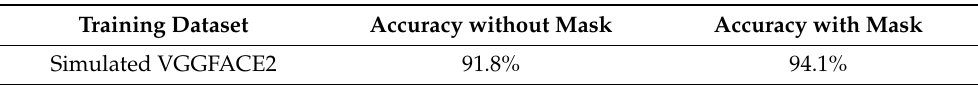
Table 6. The accuracy of face recognition without and with a mask in the real world with simulated